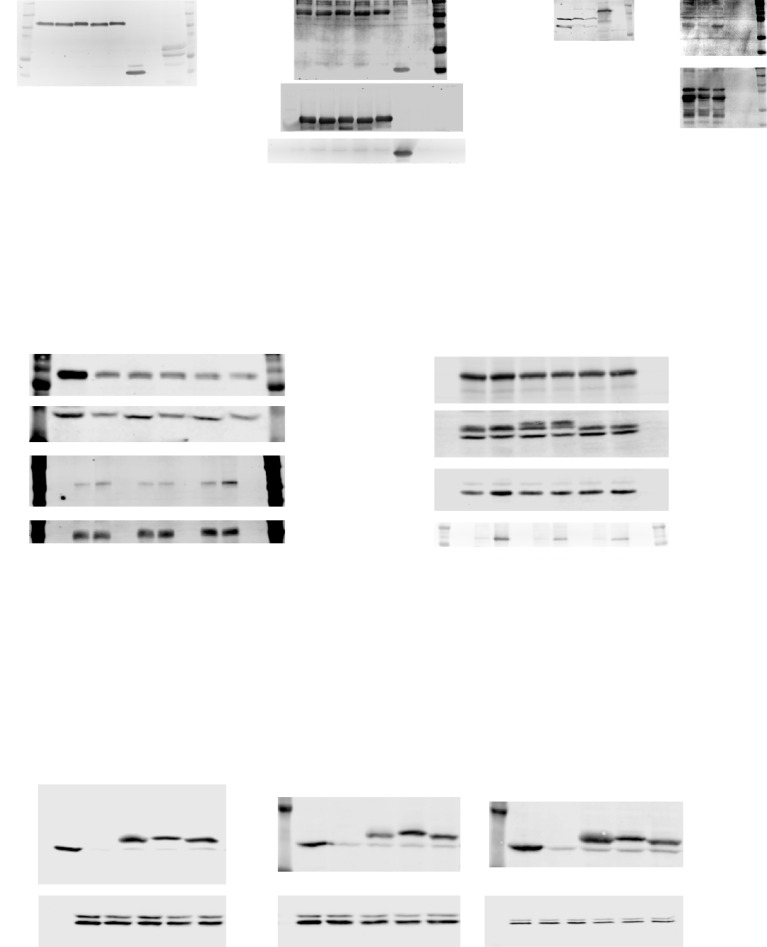
Non-cropped images of western blots shown in the manuscript.